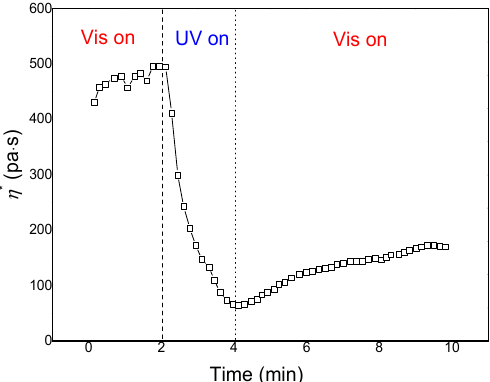
Figure 10. Real-time photo-rheology measurements (2.0 wt%). The data were obtained at a constant frequency of 5 rad/s and a strain of 1.0%. UV turned on at 2 min.